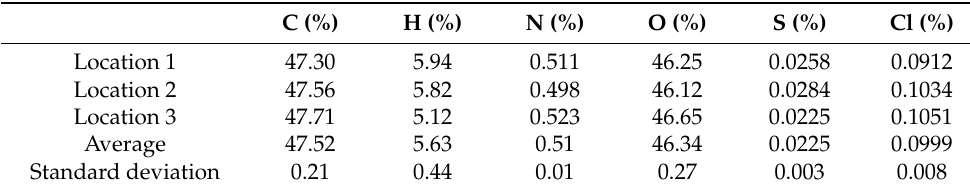
Table 2. Elemental analysis with Cl and S of A. altissima